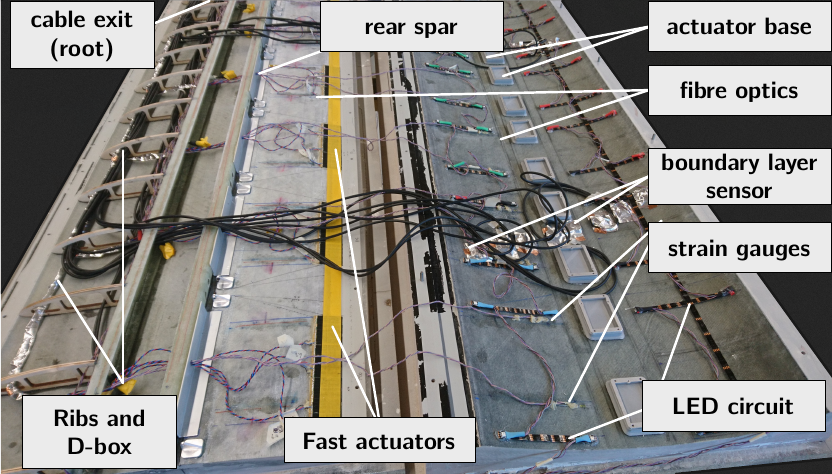
Figure 11. SmartX-Alpha sensor hardware integration and